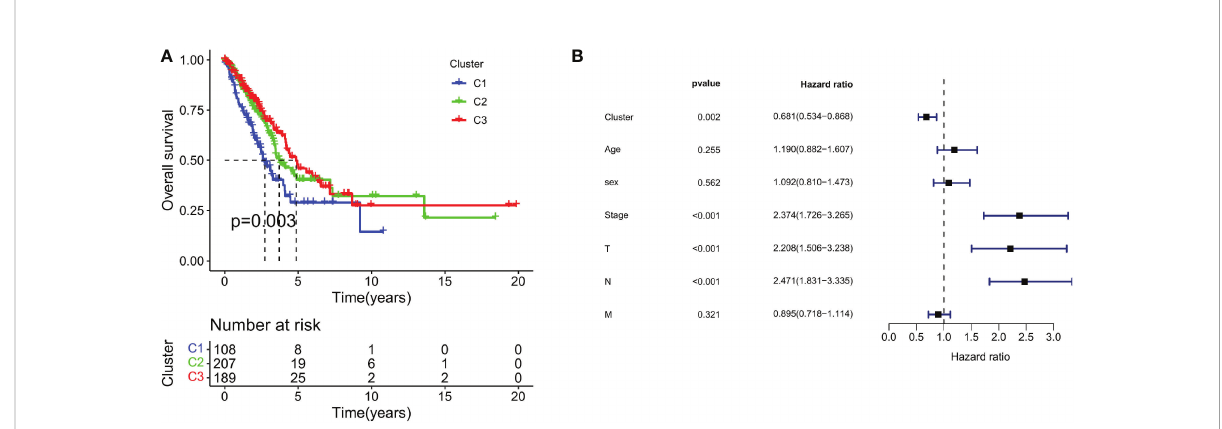
FIGURE 3 Survival outcomes of immune signature-based subtypes. (A) Survival analysis of three clusters; (B) Multivariate Cox regression analysis of clusters and clinical